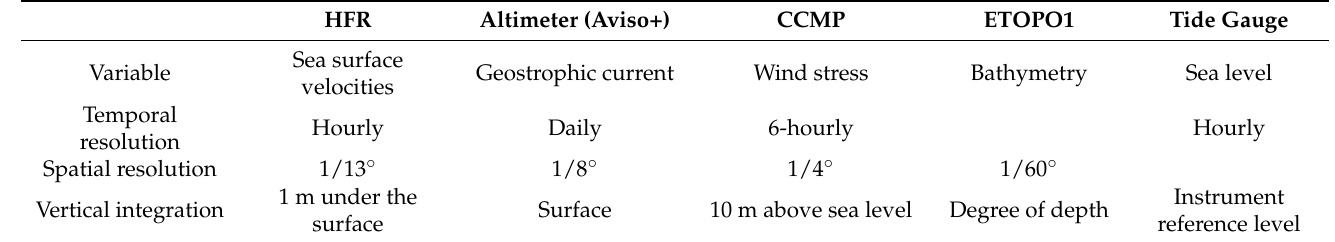
Table 1. Summary of the key dataset